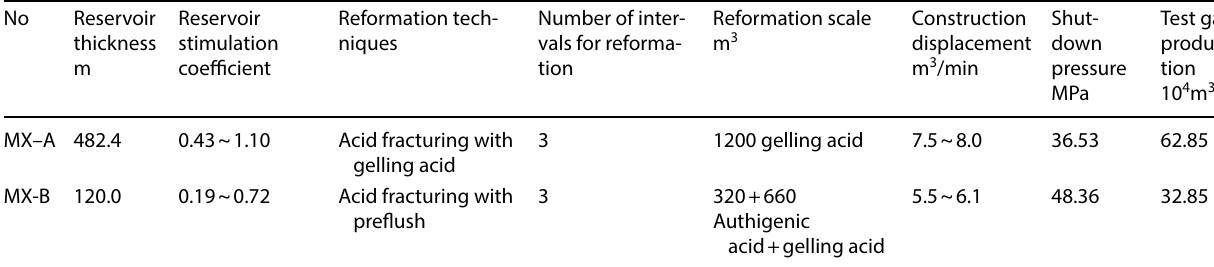
Table 6 Statistics of reservoir stimulation effect of the Deng-4 member No Reservoir